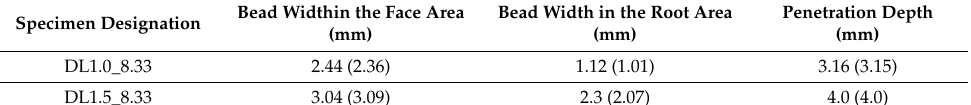
Table 2. Comparison of geometric dimensions of beads in bead-on-plate welding tests performed on a 4.0-mm-thick sample of AISI304 steel using the Trumpf TruDisk 3302 disk laser with values obtained from numerical analysis (values in brackets) (Figure 7).